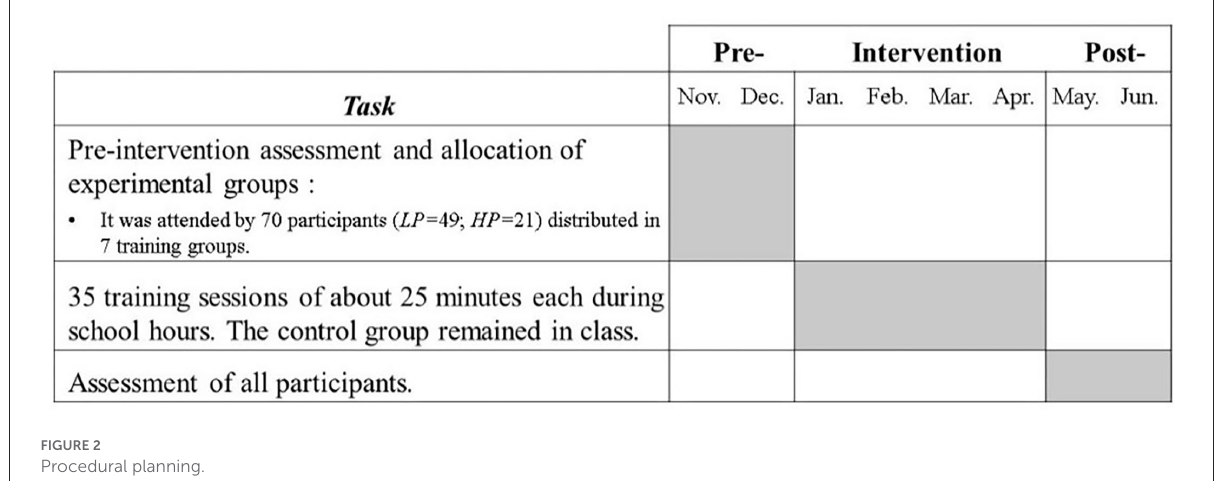
FIGURE2 Procedural